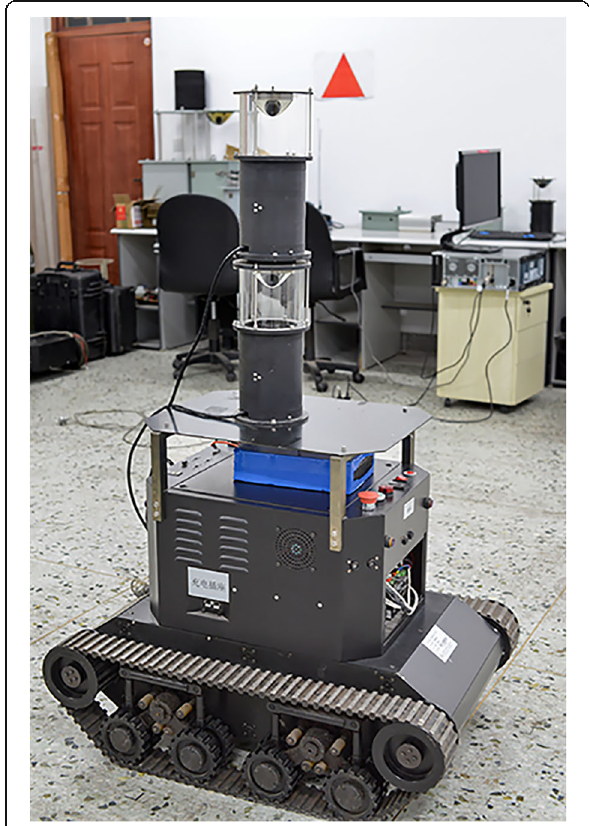
Fig. 8 V-binocular omnistereo vision system equipped on a crawler-type intelligent mobile